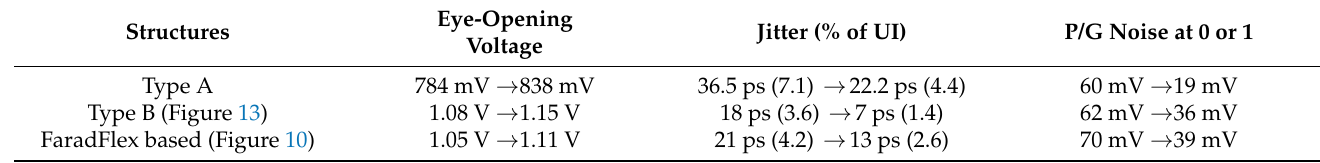
Table 5. Summary of the eye diagram improvement by adopting the proposed